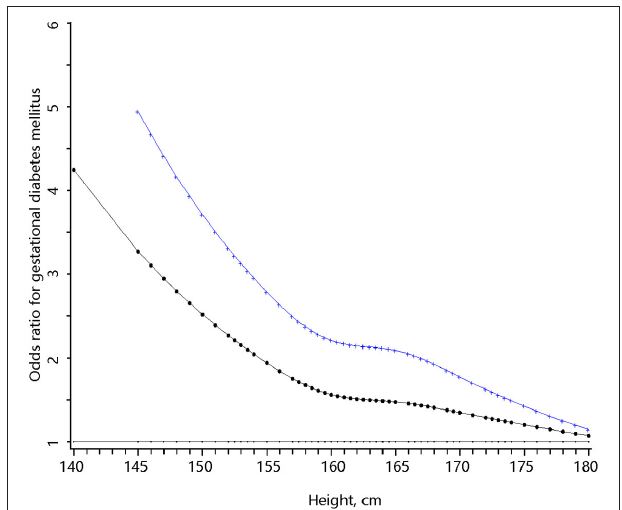
FIGURE 1 | The full range association between body height and the risk of gestational diabetes mellitus. The bottom (dotted) curve was derived from univariable analysis and the upper (cross) curve was derived from multivariable analysis that adjusted for pre-pregnancy body mass index, weight gain per week from first antenatal care visit to glucose challenge test (GCT), age, habitual smoker and drinker, Han-ethnicity, parity, systolic, and diastolic blood pressure at GCT, education, family history of diabetes, and baby